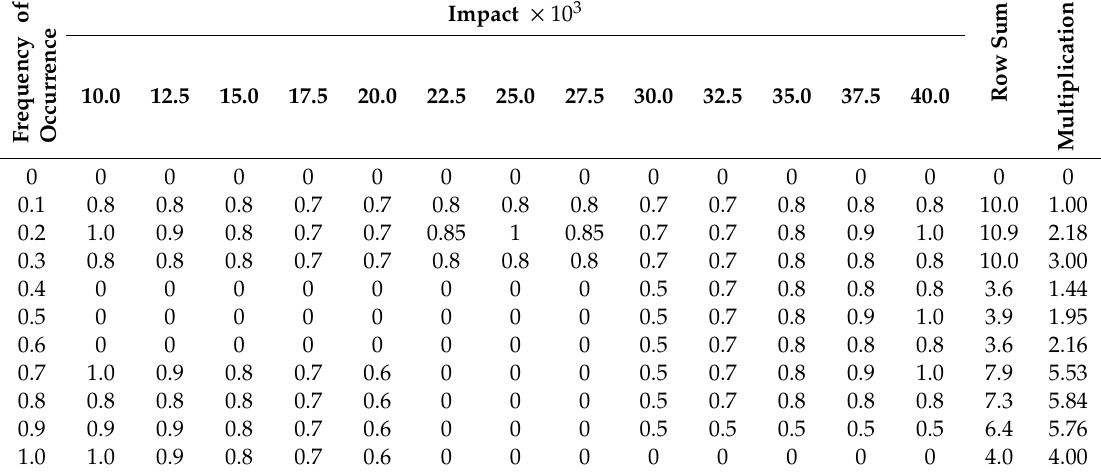
Table 9. Composition matrix U ◦ V of all relationships between adverse consequence ( C ) and impact ( I